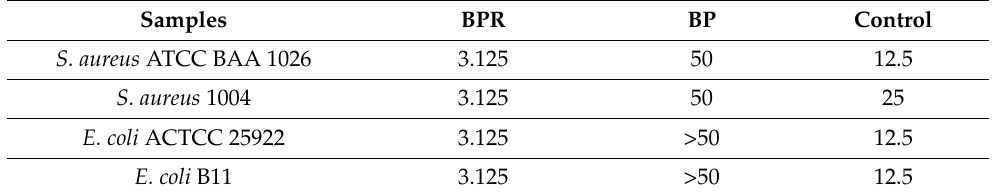
Table 1. MIC (%) of plant extracts against bacterial strains.